Question: Briefly state, in one sentence, what is plotted here.
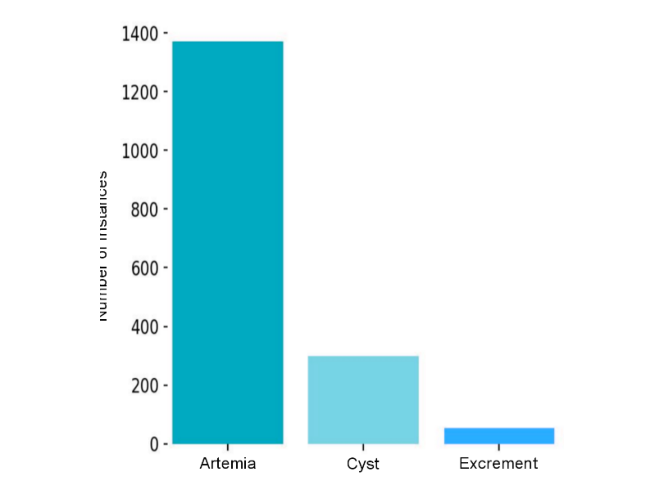
Answer: Number of class-instances